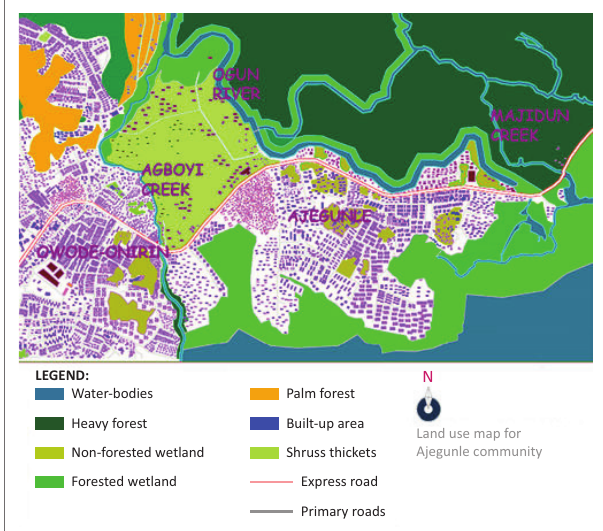
FIGURE 2: A section of Ajegunle with accumulation of stagnant water after a torrential